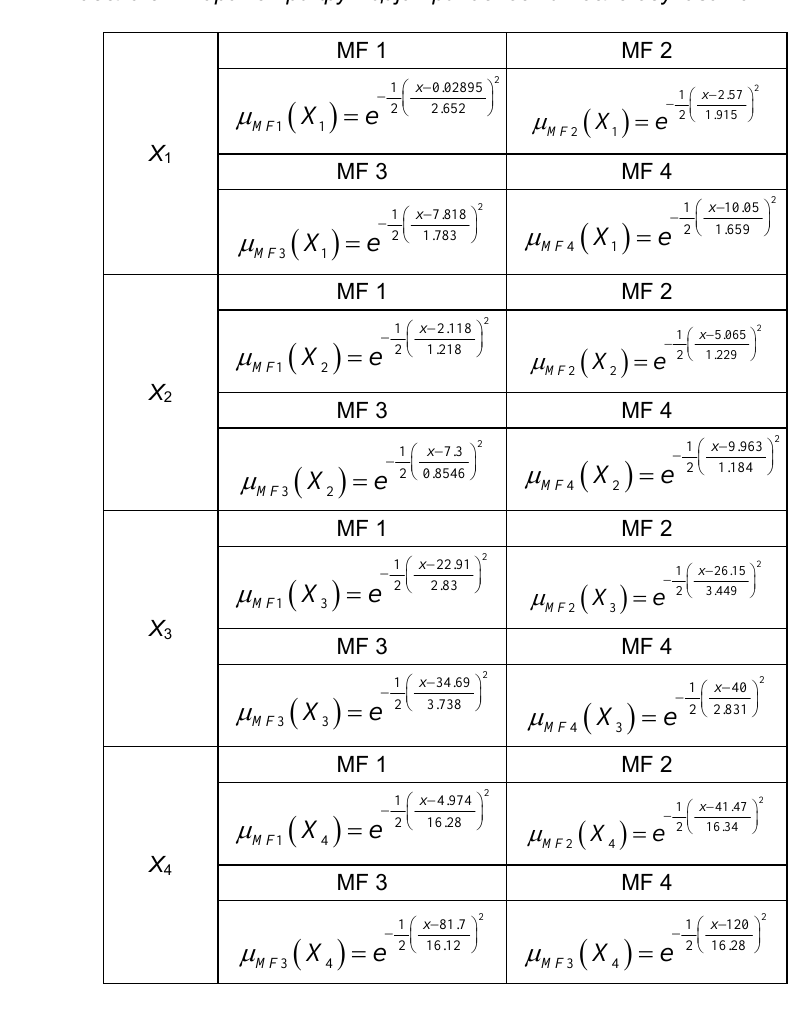
Table 5 – Parameters of the membership functions after the ANFIS